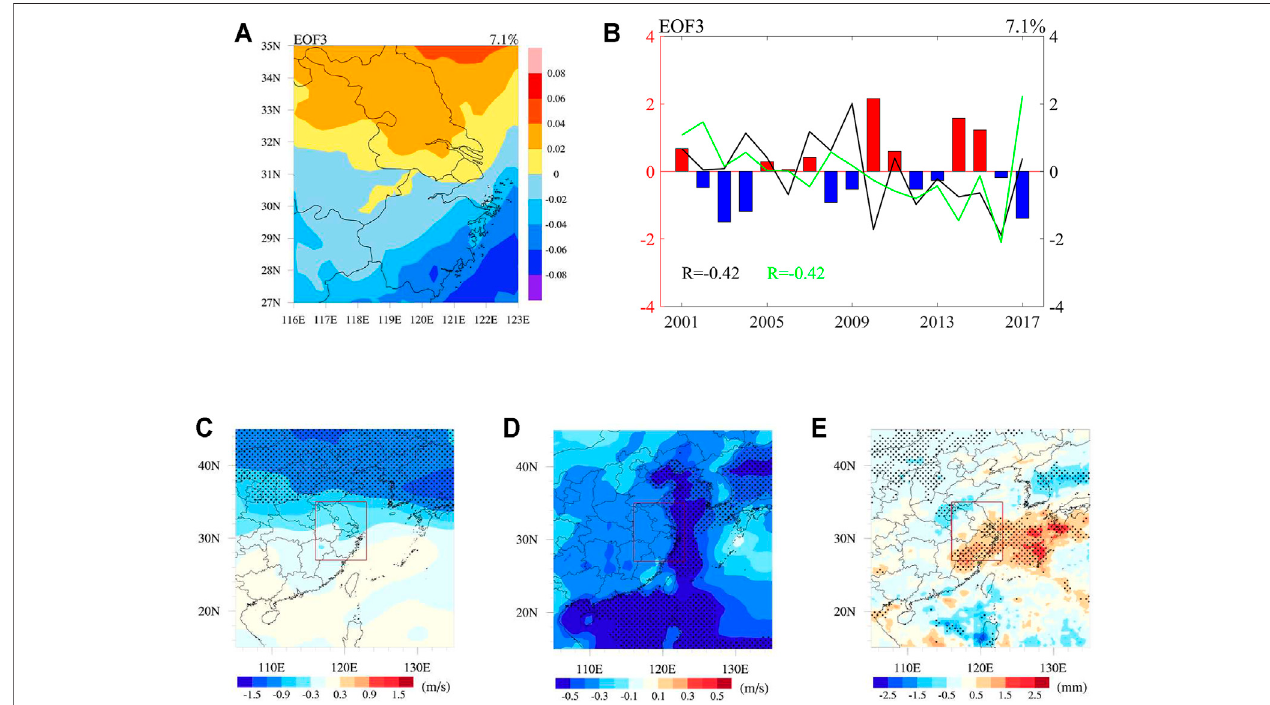
FIGURE 5 | The results for the third EOF (EOF3), including (A) the spatial pattern of EOF3, (B) the time series of EOF3 (histogram), the northern hemisphere polar vortex(thetroposphericpolarvortex)areaindex(backsolidline)andthenorthernhemispherepolarvortexintensityindex(greensolidline),andtheregressioncoef fi cients between time series of EOF3 and (C) 500 hPa wind speed, (D) 10 m wind speed, and (E) precipitation. In (B) , the indexes are normalized. In (C) to (E) , the spotted area passes 90% of the signi fi cance test, and the red rectangular region indicates the